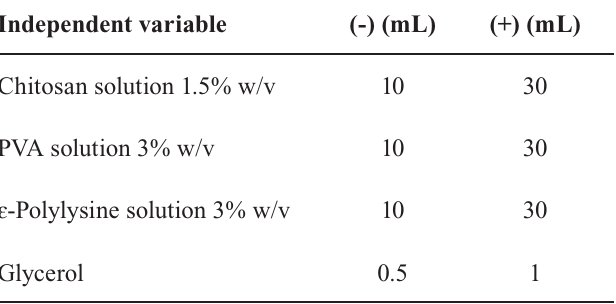
TABLE I - Values for the lower level (-) and upper level (+) of independent variables evaluated in the factorial designs Independent